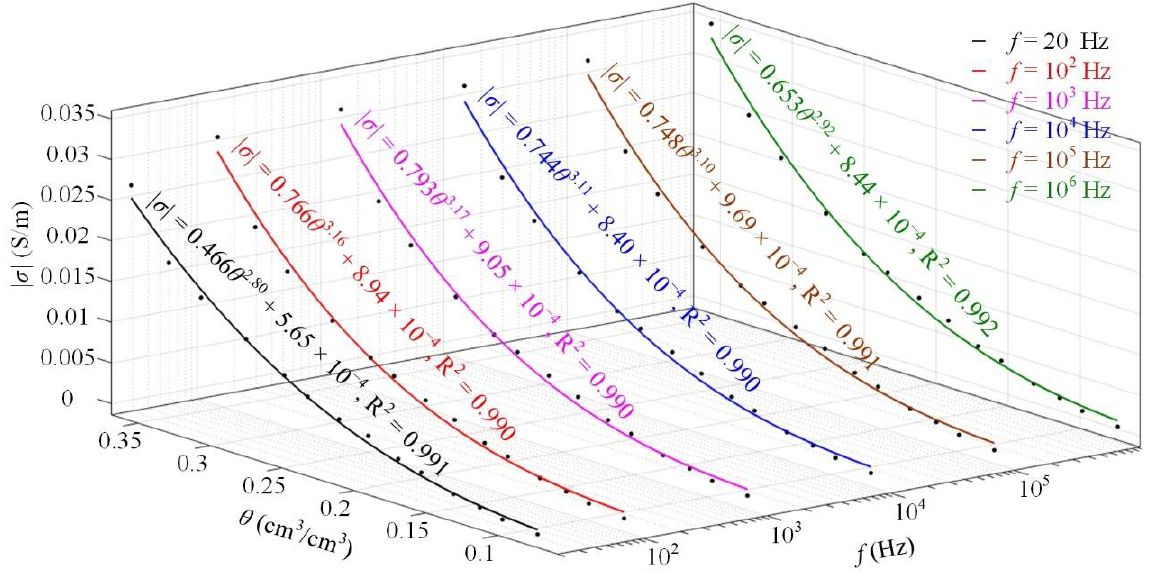
Figure A5. Fitted relations between substrate conductivity magnitude and volumetric water content at different frequencies for a typical set of substrates at nearly equal dry densities. The mean and standard deviation of the related dry densities (Table 1) are of 0.398 g/cm 3 and 4.97 × 10 −3 , respectively.